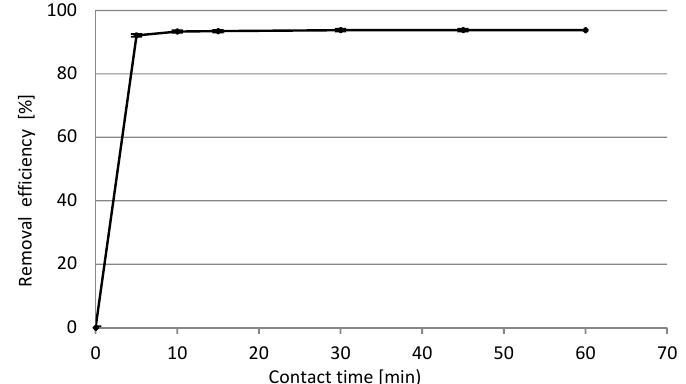
Figure 14. The impact of contact time on the Cd(II) ions biosorption efficiency.